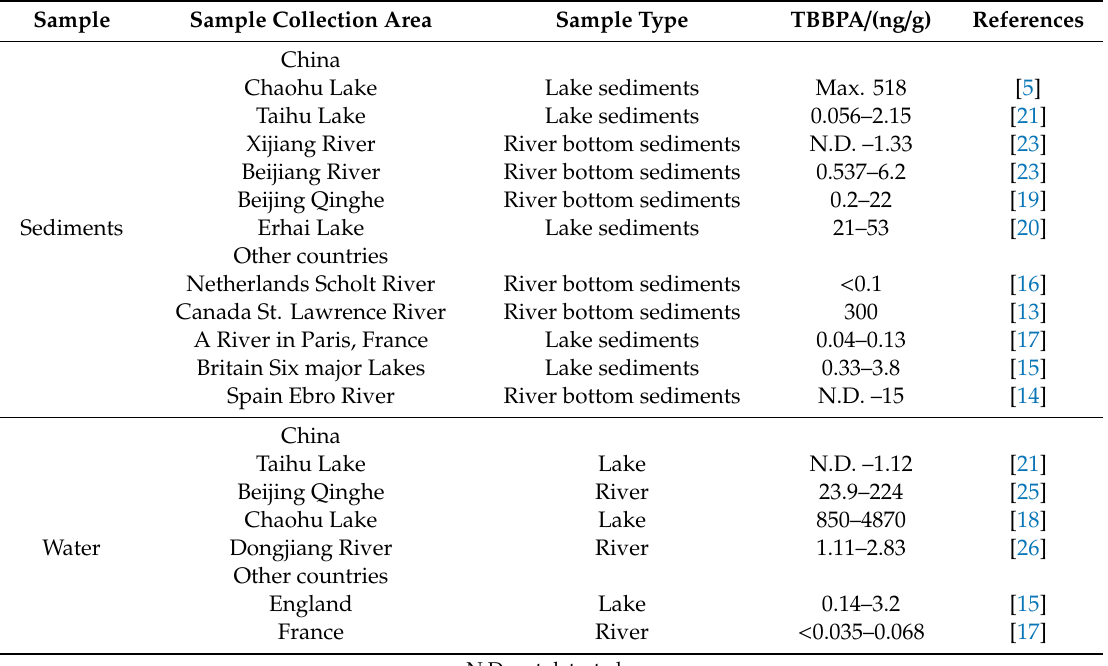
Table 2. The comparison of TBBPA content in sediment and water from home and